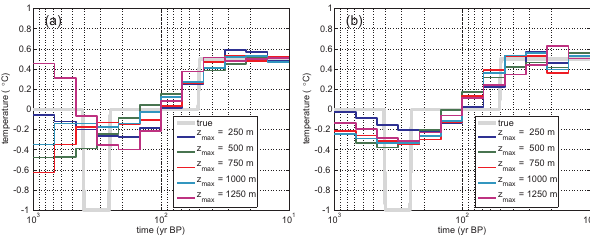
Fig. 2. Results of the Monte Carlo study. Normalized histogram densities of the temperature deviation calculated for the long-term models with respect to steady-state conditions (a) , and the vertical derivative (b) of temperature as functions of depth. For all figures, the integral along the x-axis is equal to 1 for all depths, as the den- sities are normalized by the number of runs (10000).